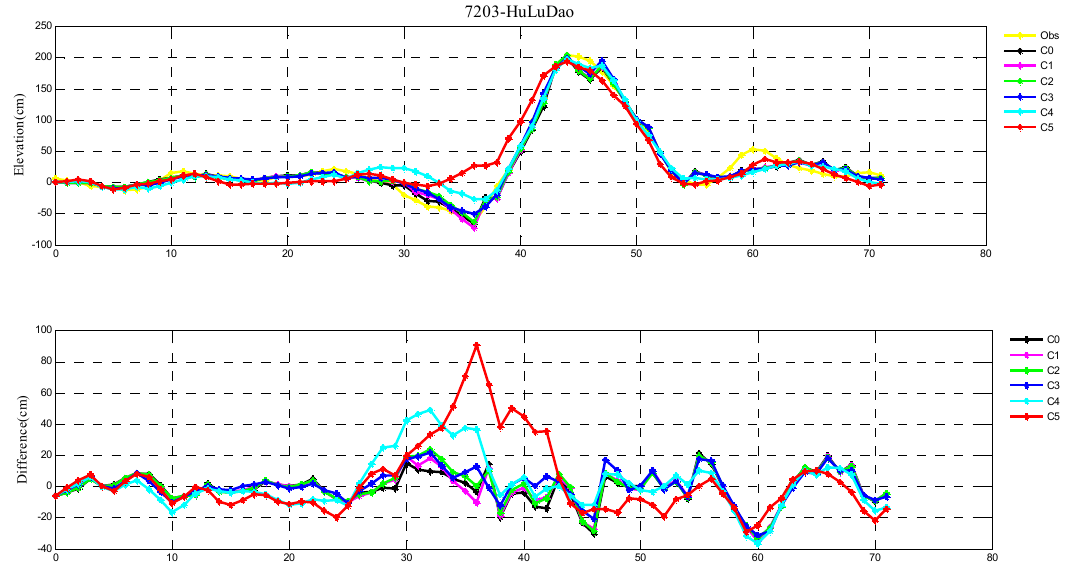
Figure 2. The storm surge elevations (cm) in six cases (C0, C1, C2, C3, C4, C5) and observations (yellow line) (top) and the differences between them (bottom) during Typhoon 7203 at DaLian tide station.